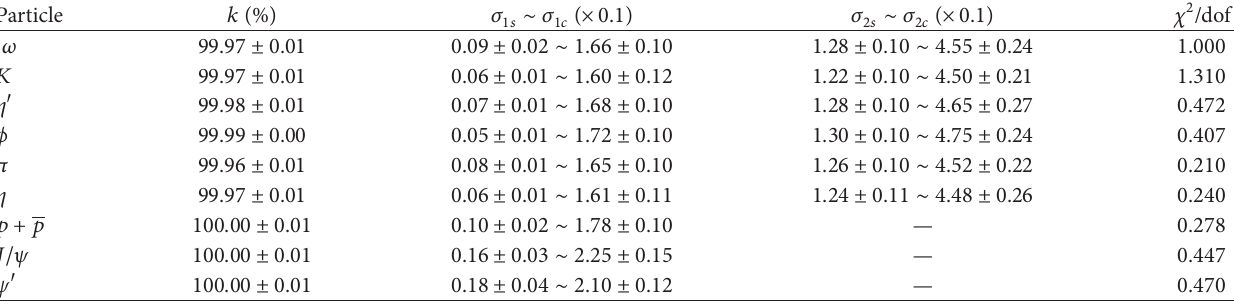
Table 1: Values of the parameters 𝑘 , 𝜎 1𝑠 ∼ 𝜎 1𝑐 , and 𝜎 2𝑠 ∼ 𝜎 2𝑐 obtained by fitting the experimental 𝑝 𝑇 spectra in Figures 1, 2, and 3. The units of 𝜎 1𝑠 , 𝜎 1𝑐 , 𝜎 2𝑠 , and 𝜎 2𝑐 are GeV/c.